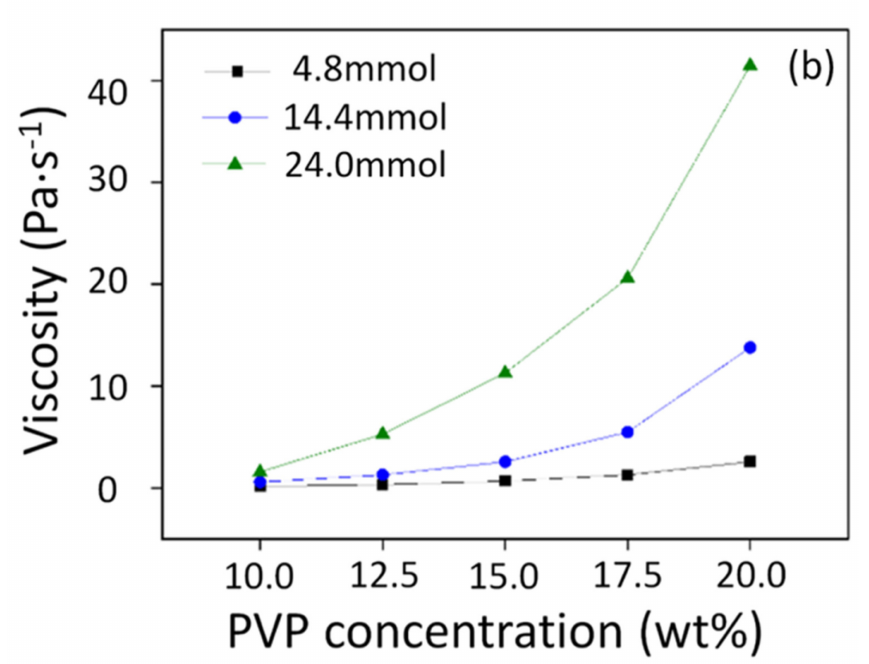
Figure 2. Surface tension ( a ) and viscosity ( b ) of each precursor solution.